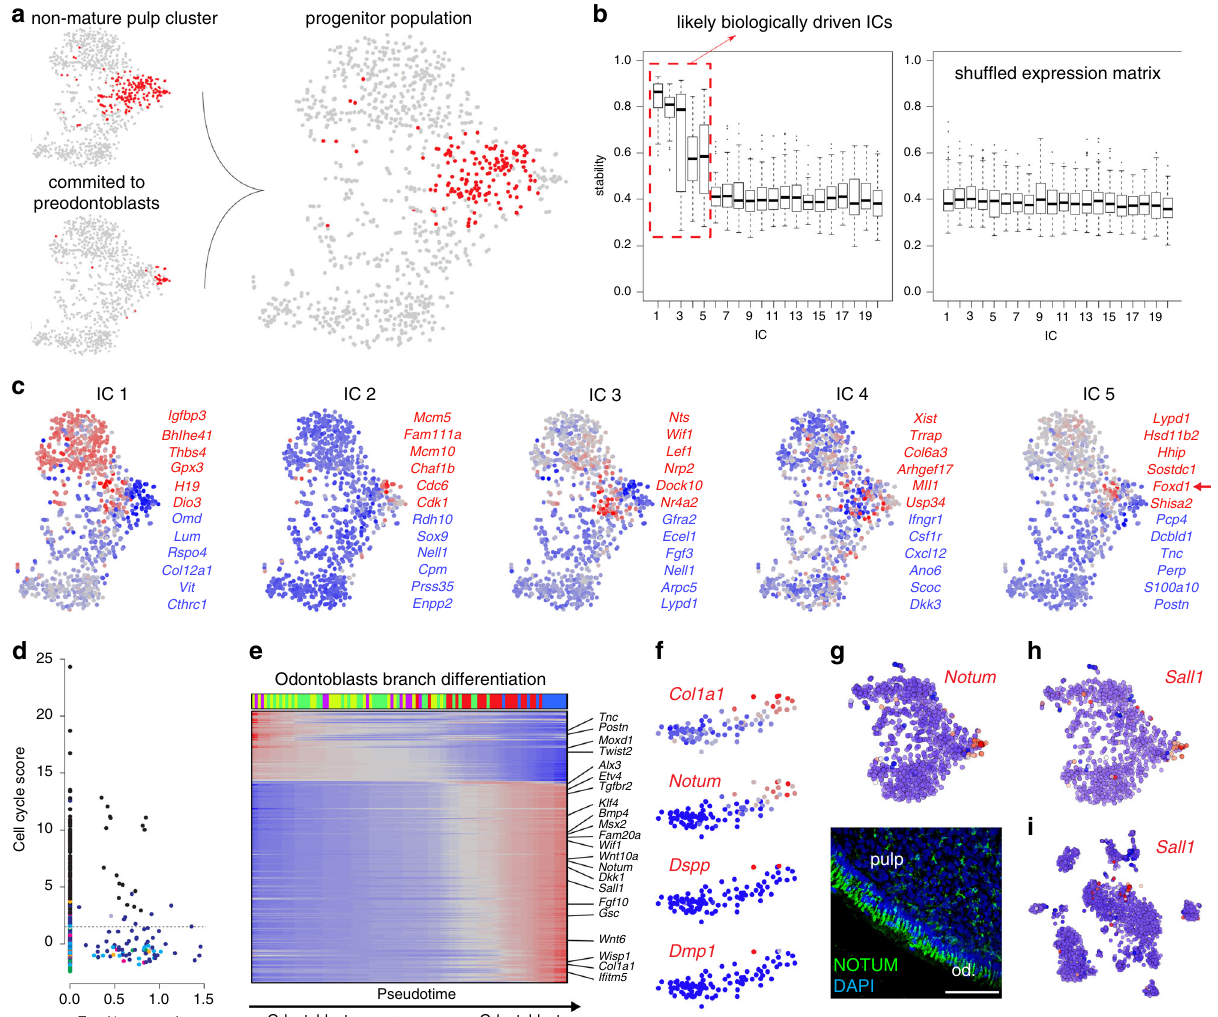
Fig. 7 Detailed analysis of mesenchymal branching point and odontoblast lineage. a Selection of non-mature subpopulation. An unbiased cluster of cells that do not represent mature pulp populations was selected (left, upper), and preodontoblasts (left, lower), were excluded from it, resulting in non-mature subpopulation (right). b Analysis of ICs stability reveals fi ve biologically driven aspects of heterogeneity of non-mature subpopulation. Average correlation of ICs to the most similar ICs across 100 runs of subsamplings of 70% of cells (right) reveals 5 out of 20 ICs with stability substantially higher than expected from shuf fl ed control (left). Stability of all ICs of control shuf fl ed matrix and 15 ICs of original matrix are around 0.4 indicating background expectations of spurious components. c Five ICs of non-mature subpopulation reveal processes related to (from left to right) apical gradient (IC 1), cell cycle (IC 2), Fgf3 -mediated (IC 3), and Foxd1 -mediated (IC 5) heterogeneity restricted to the progenitor states. Colors show intensities of identi fi ed ICs. Genes that have the highest (red) and lowest (blue) associations with corresponding IC are shown. d Graph showing cells expressing Foxd1 in comparison to cell-cycle score. e Transcriptional events during pulp differentiation trajectories. Each trajectory encompasses cell states from progenitor, as identi fi ed from analysis of preodontoblasts, to mature states with cells arranged by pseudotime re fl ecting maturation process. The black cells belong to the trajectory being shown, while other cells are shown in light gray (upper panels). Heatmap shows smoothed gene expression pro fi les with cells arranged by pseudotime and genes (rows) arranged by pseudotime of maximal expression (lower panels). f – i Expression analysis of the selected genes determining odontoblasts ( Col1a1, Dmp1, and Dspp ) and together with previously unrecognized identi fi ed odontoblast marker genes ( Notum and Sall1 ). Notum expression is visualized on t-SNE embedding of the pulp dataset and immunohistochemistry proves NOTUM to be expressed in odontoblasts ( g ). Sall1 expression is visualized on t-SNE embeddings of the both pulp ( h ) and complete incisor dataset ( i ). Scale bars: 50 µ m.